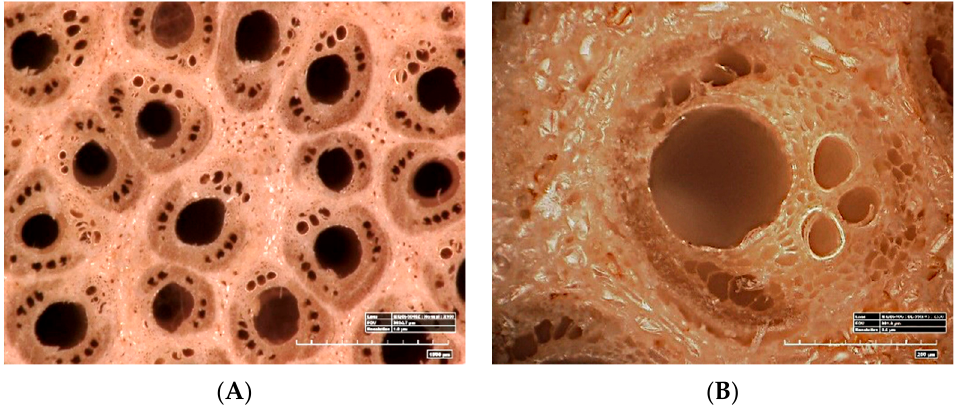
Figure 2. Images of the physical characteristics of dried rattan pieces obtained by 3D digital microscopy ( A ) 100× and ( B ) 350×.